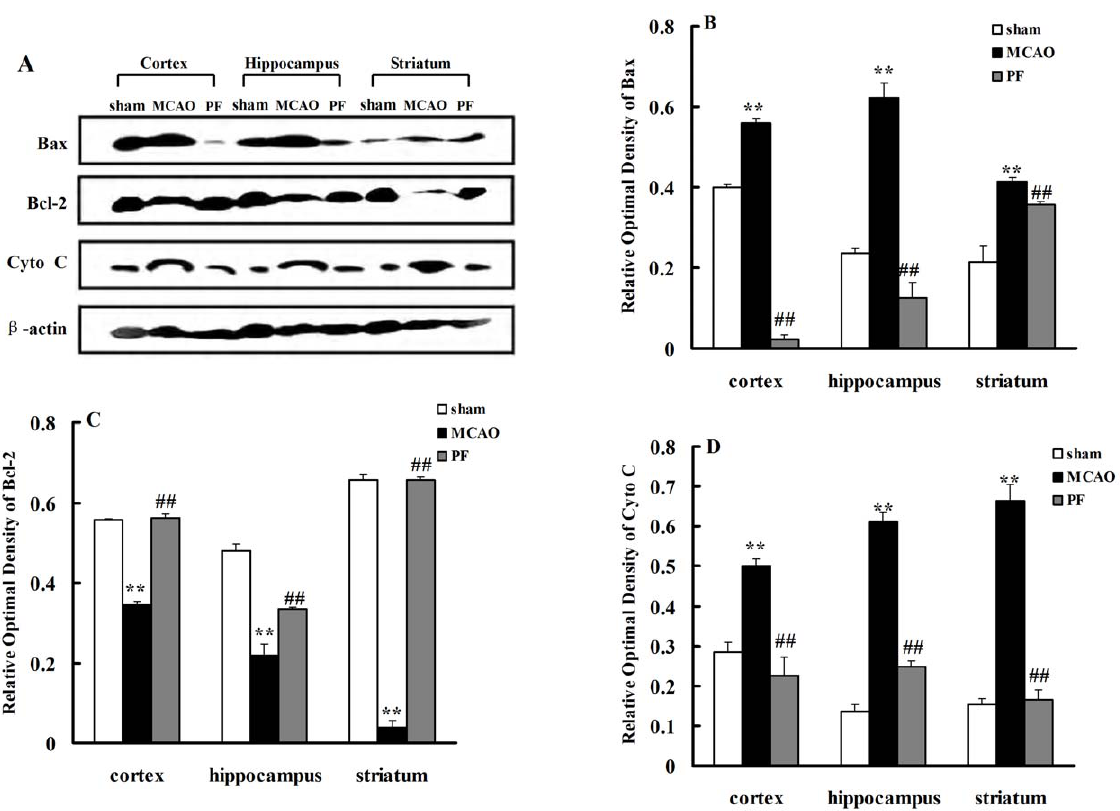
Figure 7. PF treatment decreases expressions of cytochrome c and Bax, but increases the expressions of Bcl-2. Cytochrome c, Bax and Bcl-2 protein expressions in the cortex, hippocampus and striatum of rats were indicated in (A). The relative optical densities were indicated in (B–D). Sham, rats received surgery without vessel occlusion; MCAO, rats treated with saline for 14 days after transient MCAO; PF, PF (5 mg. kg 2 1 ) was administered for 14 days after MCAO. n=4. All data were expressed as mean 6 SD. ** P , 0.01 vs sham; ## P , 0.01 vs MCAO.